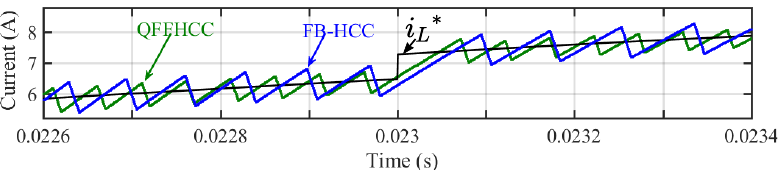
Figure 19. Comparison of transient response in the case of FB-HCC and the